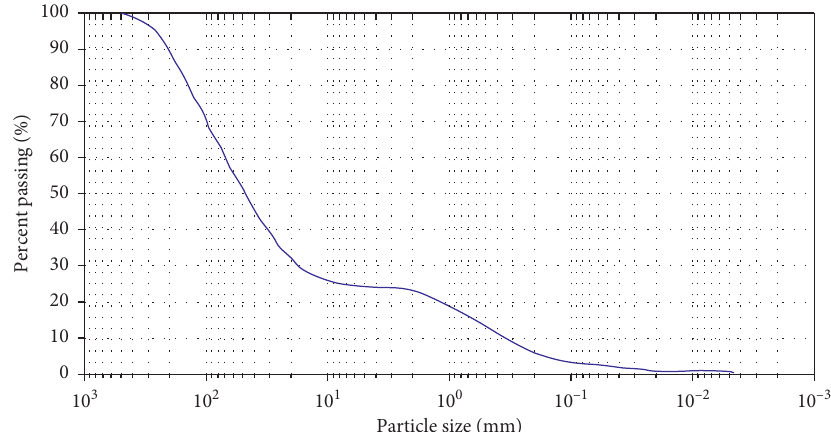
Figure 4: Characteristic grading curve of the strata.